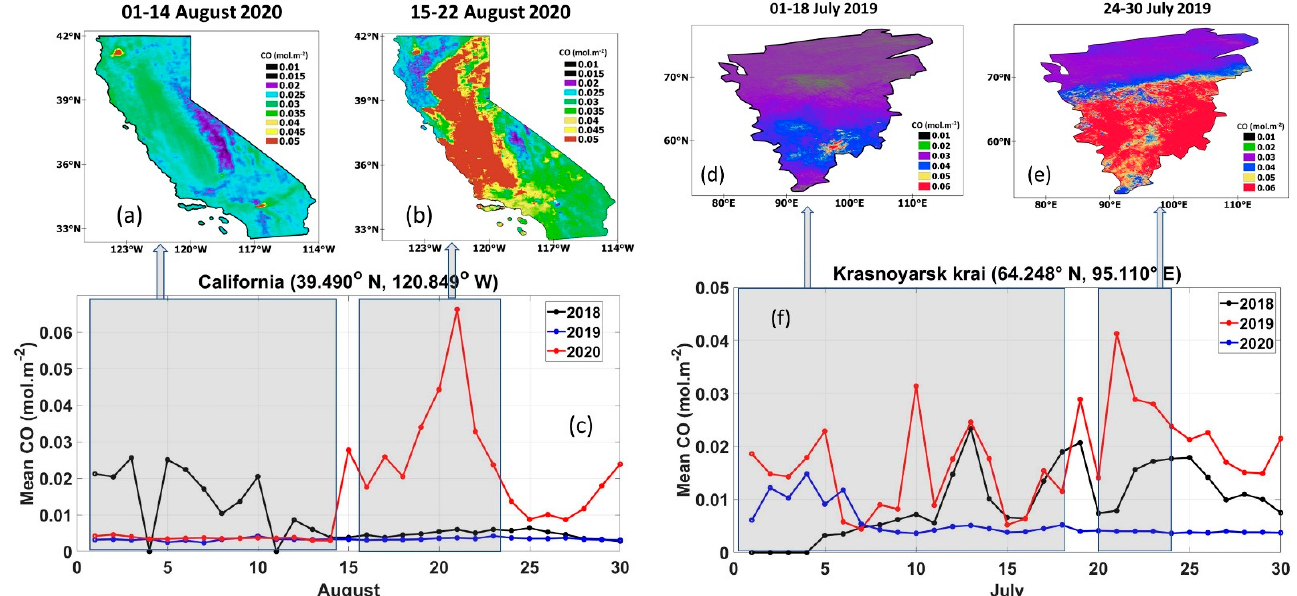
Figure 2. CO distribution over California on ( a ) 1–14 August 2020 and ( b ) 15–22 August 2020. ( c ) Daily mean BC column burden for the period of 1–30 August 2020. CO distribution over Krasnoyarsk Krai on ( d ) 1–18 July 2019 and ( e ) 24–30 July 2019. ( f ) Daily mean BC column burden for the period of 1–30 July 2019.